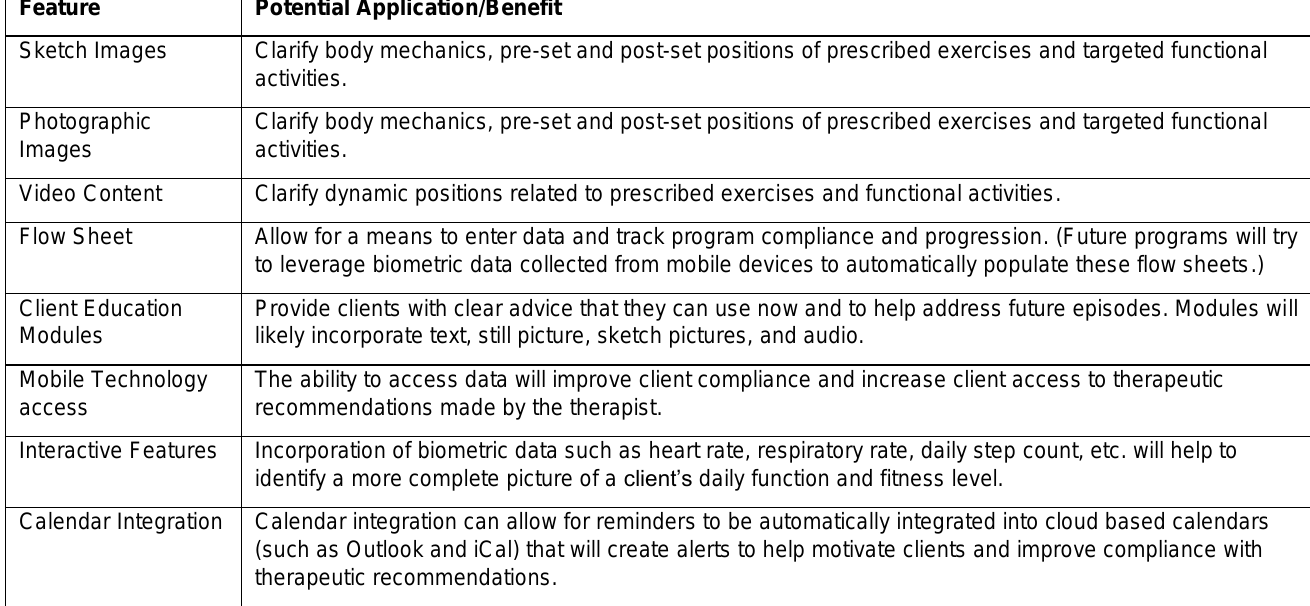
Table 2. Benefits of Asynchronous (Store and Forward)